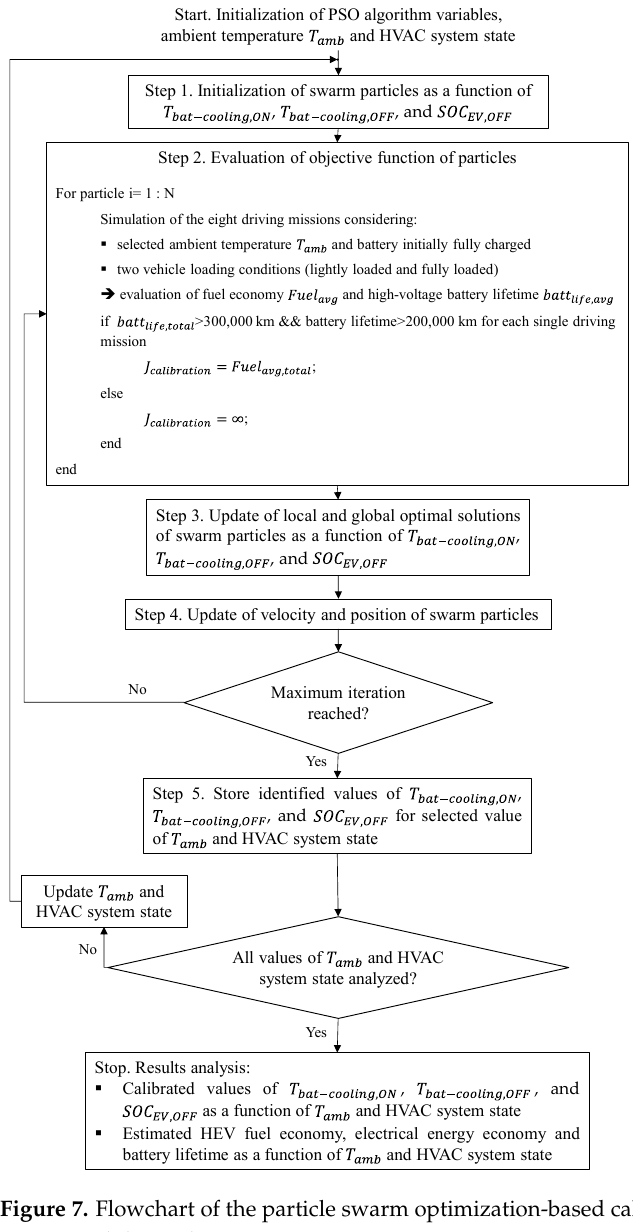
Figure 7. Flowchart of the particle swarm optimization-based calibration of the parameters for HEV energy and thermal management.